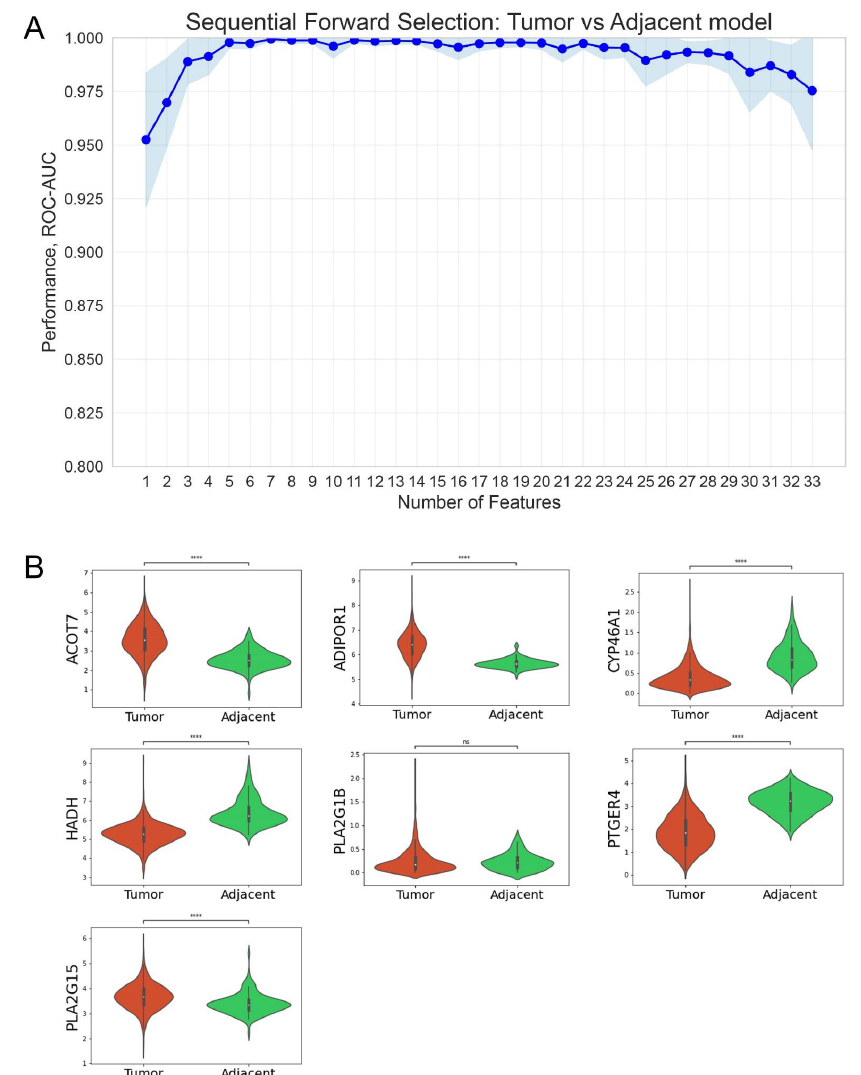
Figure 3. **** p < 0.0001. Identification of the minimal PUFA gene set required for efficient classifi- cation of breast cancer and normal samples. ( A ) Light blue zones refer to 95% confidence intervals. ( B ) Expression of ADIPOR1 , HADH , ACOT7 , PTGER4 , PLA2G15 , PLA2G1B , and CYP46A1 genes in breast cancer and normal adjacent